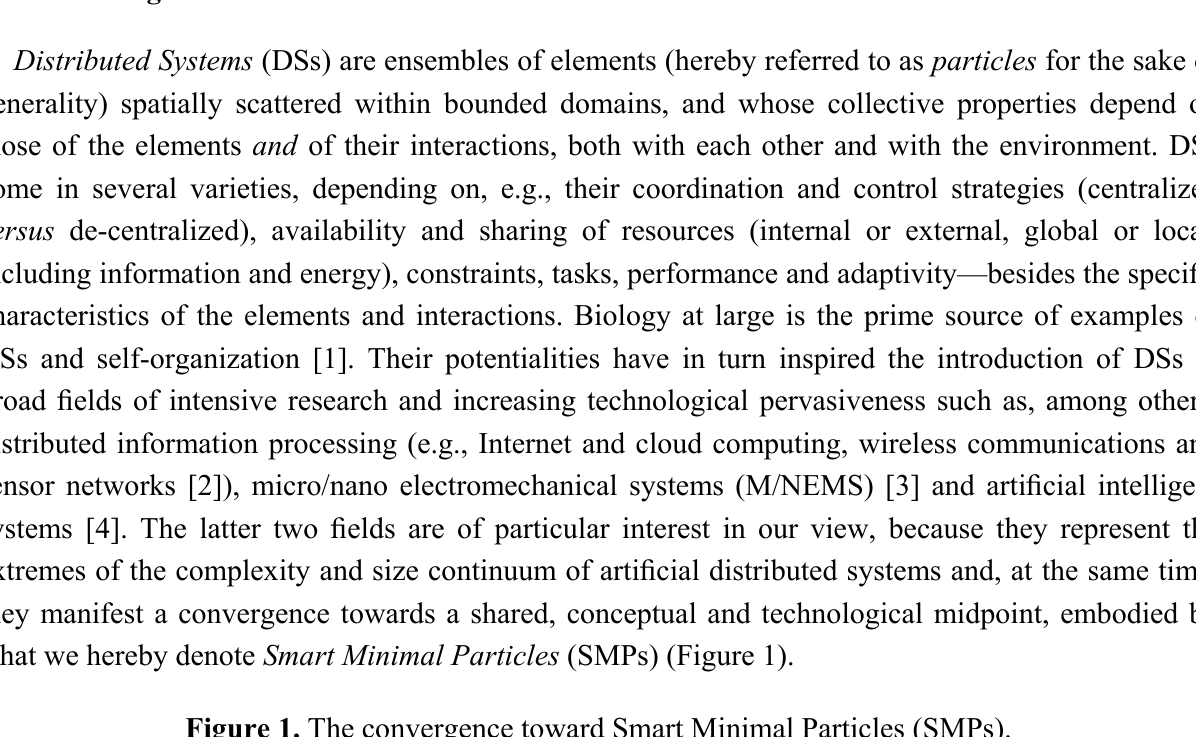
Figure 1. The convergence toward Smart Minimal Particles